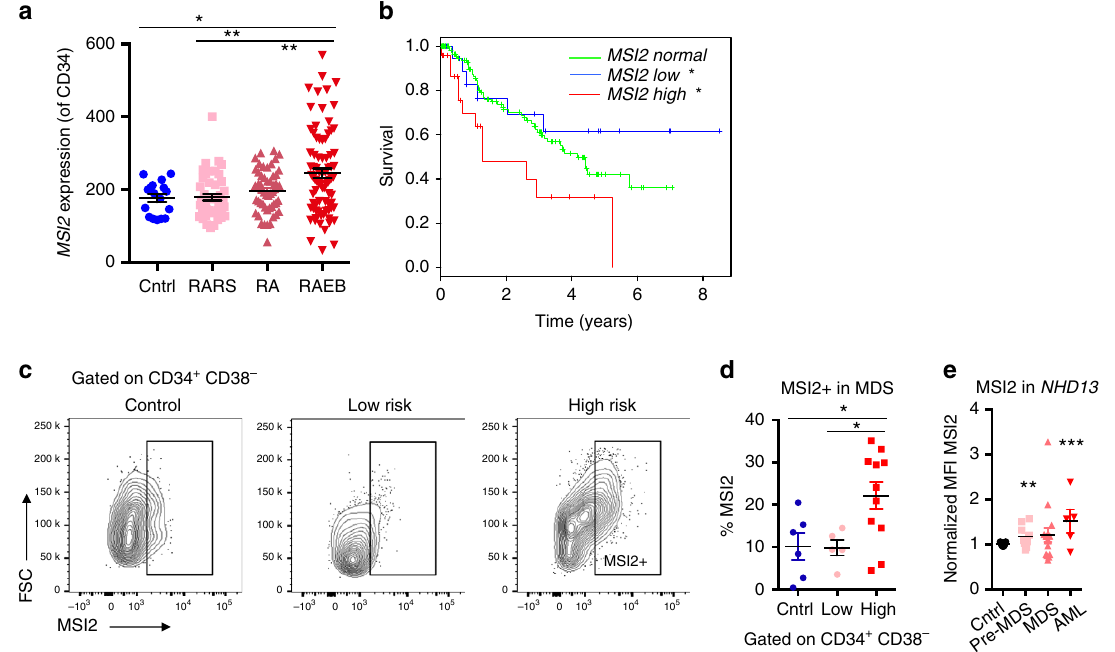
Figure 1 | Elevated MSI2 expression predicts poor survival in MDS. ( a ) Microarray expression data (CD34 þ population) from normal elderly individuals (CD34 þ ; n ¼ 17) and MDS ( n ¼ 183), RARS, RA, RAEB, * P o 0.05, ** P o 0.01, *** P o 0.001 Student’s t -test mean ± s.e.m 12 . ( b ) Overall survival in MDS patients stratified by MSI2 expression (as high ( Z -score 4 1), low ( Z -score o (cid:2) 1), or normal ( (cid:2) 1 r Z -score r 1) log-rank test. ( c ). Representative flow cytometric analysis of independent patient cohort of primary patients samples gated on CD34 þ CD38 (cid:2) and stained for intracellular MSI2, age-matched elderly individuals ( n ¼ 6), low risk (RA or RARS; n ¼ 5) and high risk (RAEB-1, RAEB-2 n ¼ 10) ( d ). MSI2 positivity summarized from gating of patients in c . ( e ) MSI2 intracellular levels in the NHD13 MDS/AML animal model. Cells are initially gated on MSI2-positive cells (Supplementary Fig. 1 for gating) and median fluorescence intensity (MFI) is normalized to the control (C57BL6 mice), n ¼ 19. Pre-MDS represents the analysis preformed in NHD13 primary or transplanted mice within 1–2 months of birth and before MDS onset ( n ¼ 9), the MDS mice that are older than 2 months or primary transplanted and have low WBC, ( n ¼ 16) and AML samples are from NHD13 mice that have transformed to AML ( n ¼ 5), d and e * P o 0.05, ** P o 0.01, *** P o 0.001 Student’s t -test horizontal line is the mean ±